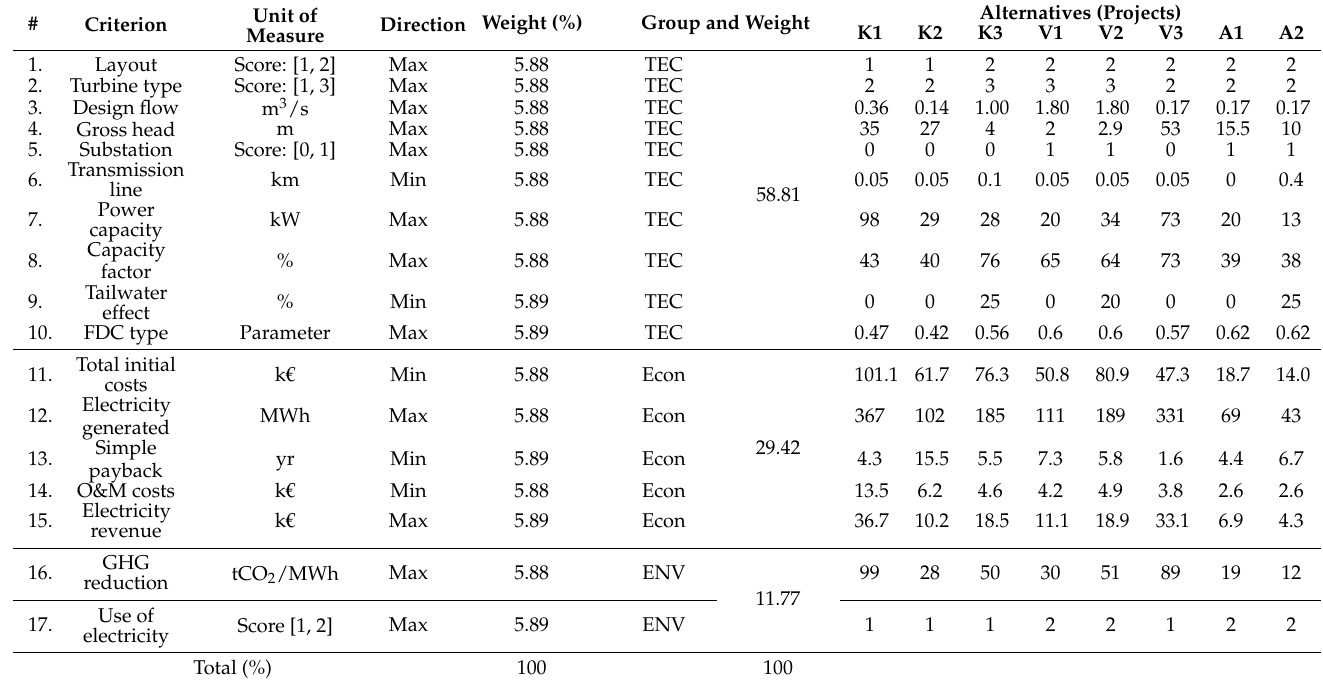
Table 3. Data employed for multicriteria analysis for installation of hydropower turbines (the basic scenario, equal weights for all criteria).